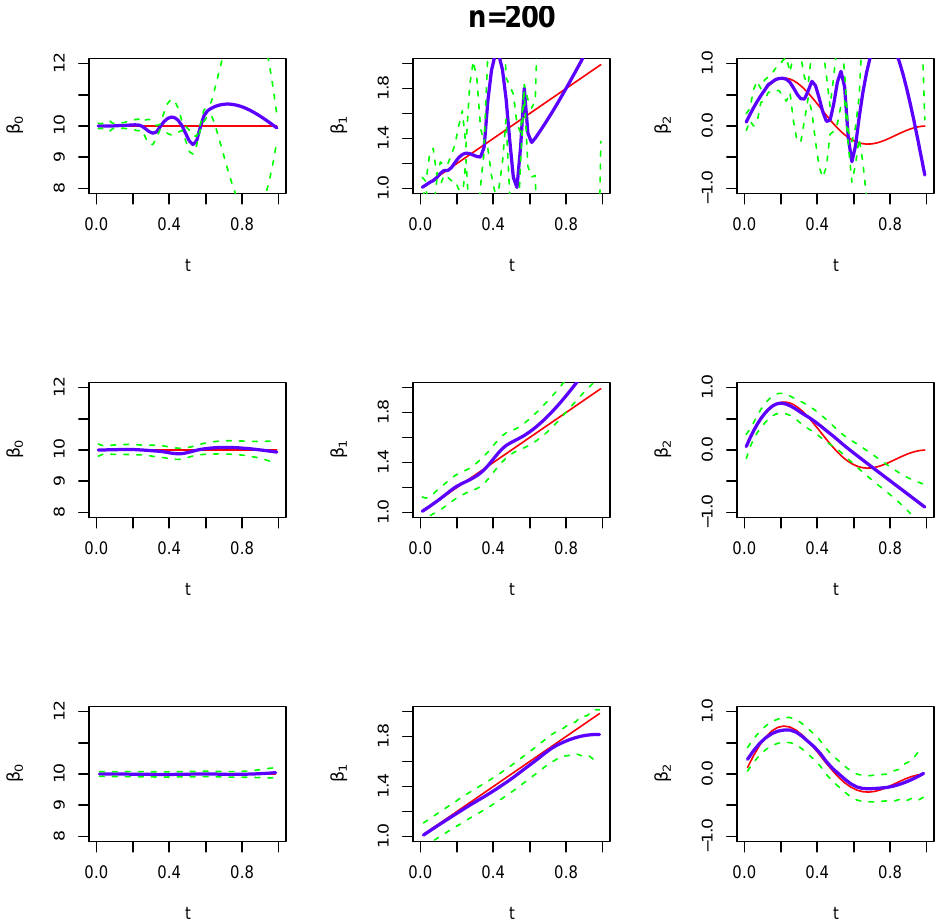
Figure 4. Performance of curve estimation when the sample size is 200 and the random seed is “set.seed(1)” in R. First row: curve estimation performance of the spline smoother; Second row: curve estimation performance of the local polynomial model; Third row: curve estimation performance of the proposed RKHS method. Solid red line: true curve; Solid blue line: estimated curve; Dotted lower and upper green lines: 95% confidence